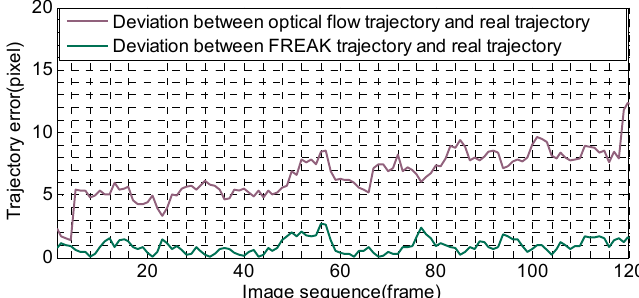
Figure 5. Trajectory tracking error of optical flow and image matching with FREAK (Fast Retina Keypoint) descriptor.